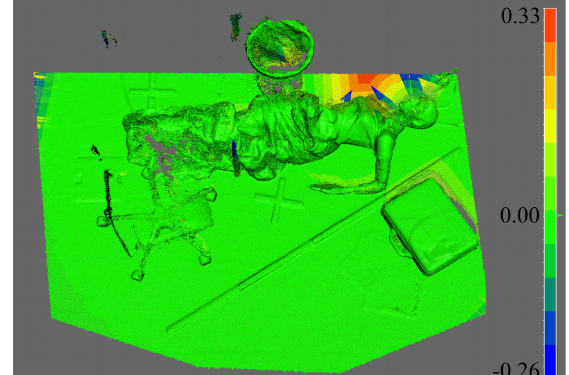
Figure 5. Distance point could light field model to laser scan. Green small distances red, larger distances. The red at the top right represents the hole in the laser scan. The colour bar on the right represents the colour coding of the discrepancies between -0.26 m to 0.33 m.